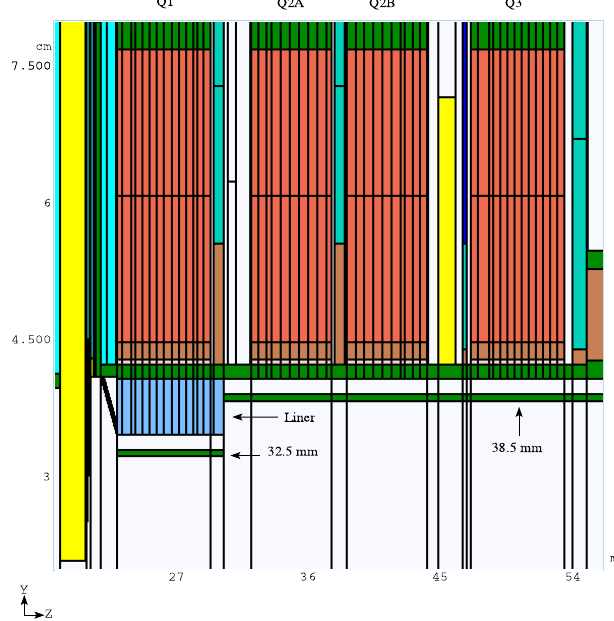
FIG. 2. (Color) Fragment of the inner triplet geometry with a baseline liner.